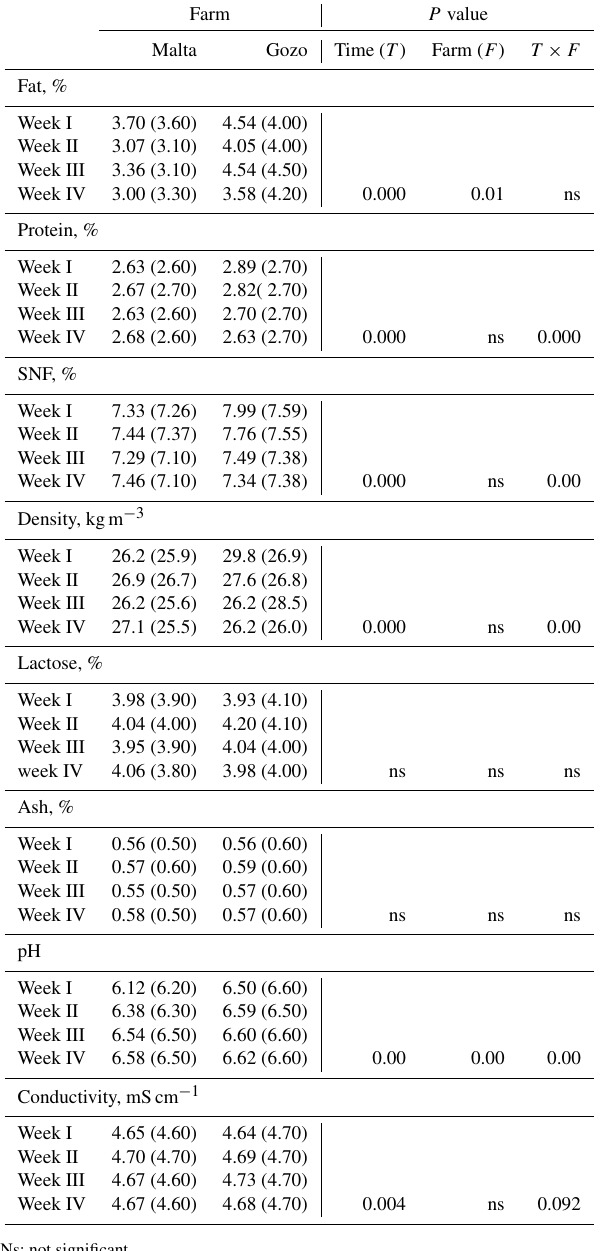
Table 4. Effect of feeding system on milk chemical composition (average of individual cows with bulk-tank values in